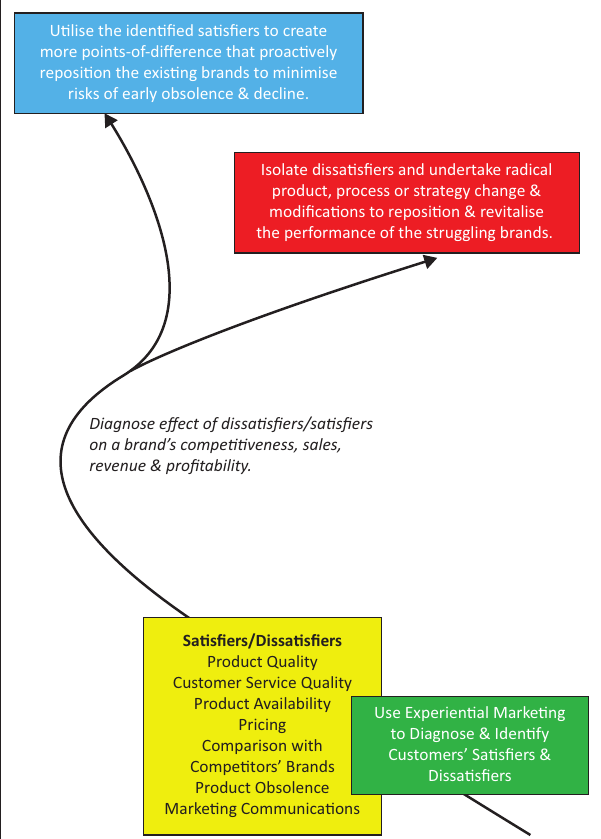
FIGURE 1: Experiential marketing framework as a basis for brand repositioning and revitalisation to enhance small and medium-sized enterprises